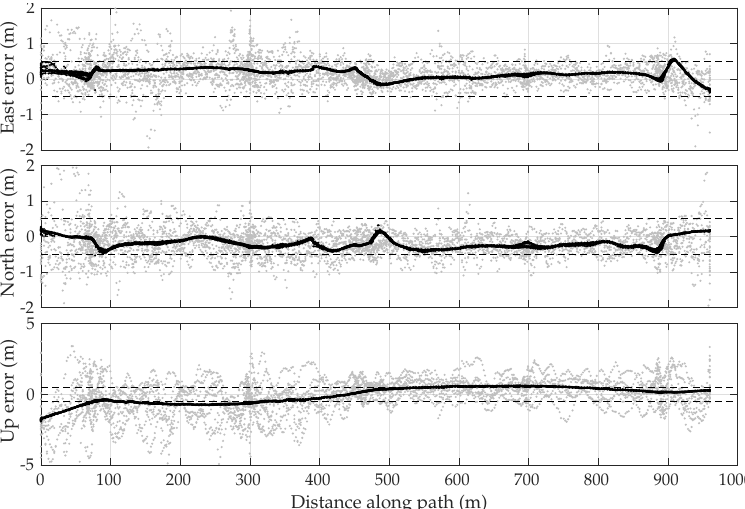
Figure 16. Errors in GEOSLAM’s estimate of the primary antenna position (in black) with respect to ground truth in the east, north, and up directions for eight mapping sessions from four different data collection campaigns. The errors in double-differenced pseudorange-based primary antenna position estimates for each of the eight sessions, fed as measurements to GEOSLAM, are plotted in gray for reference. Dashed reference lines are drawn at ± 50